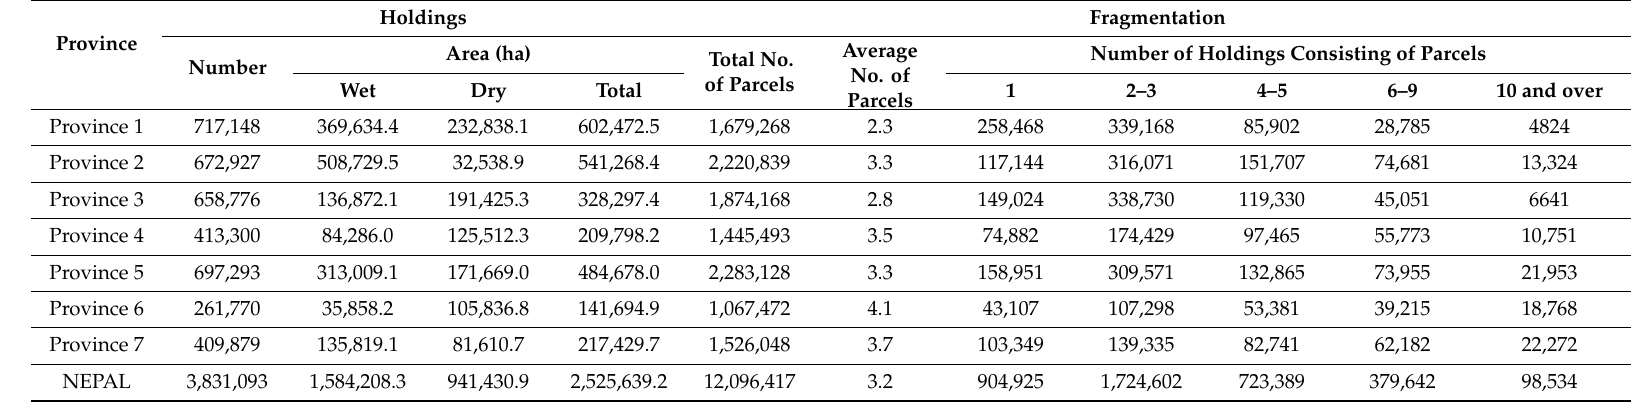
Table 4. Landholding situation in various provinces.